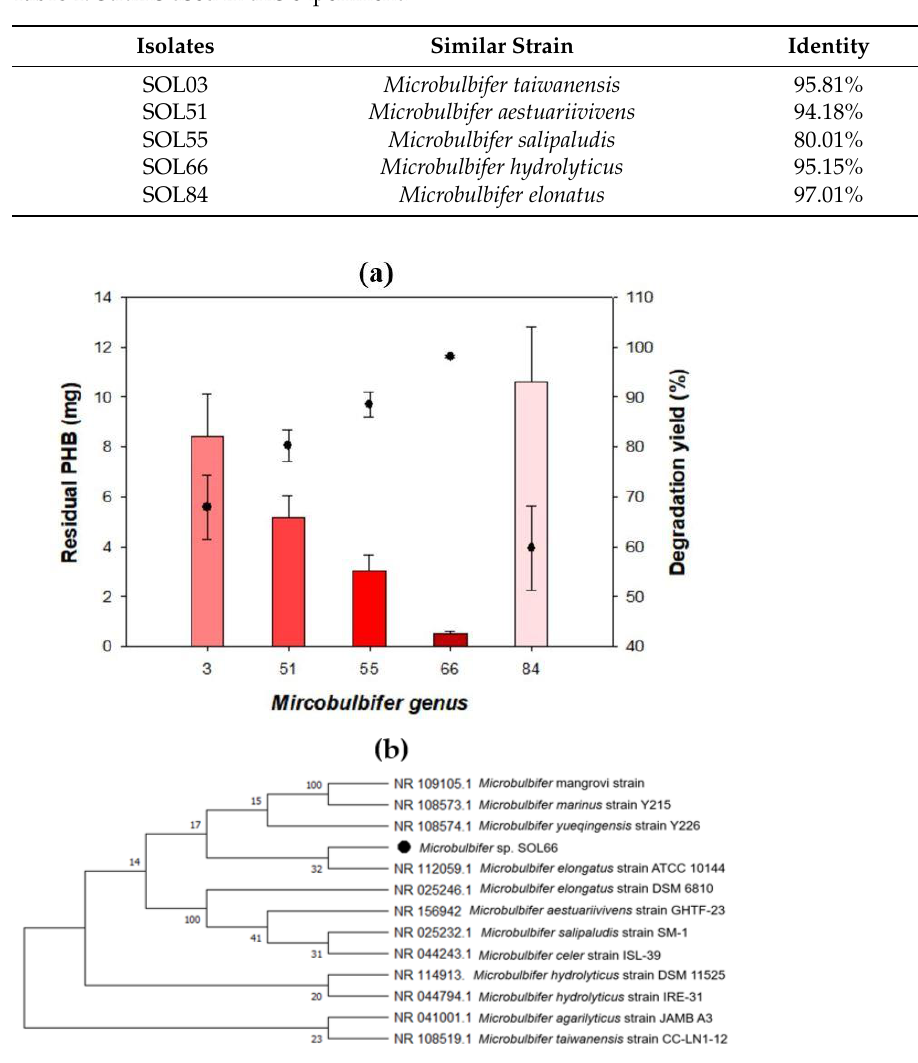
Table 1. Strains used in this